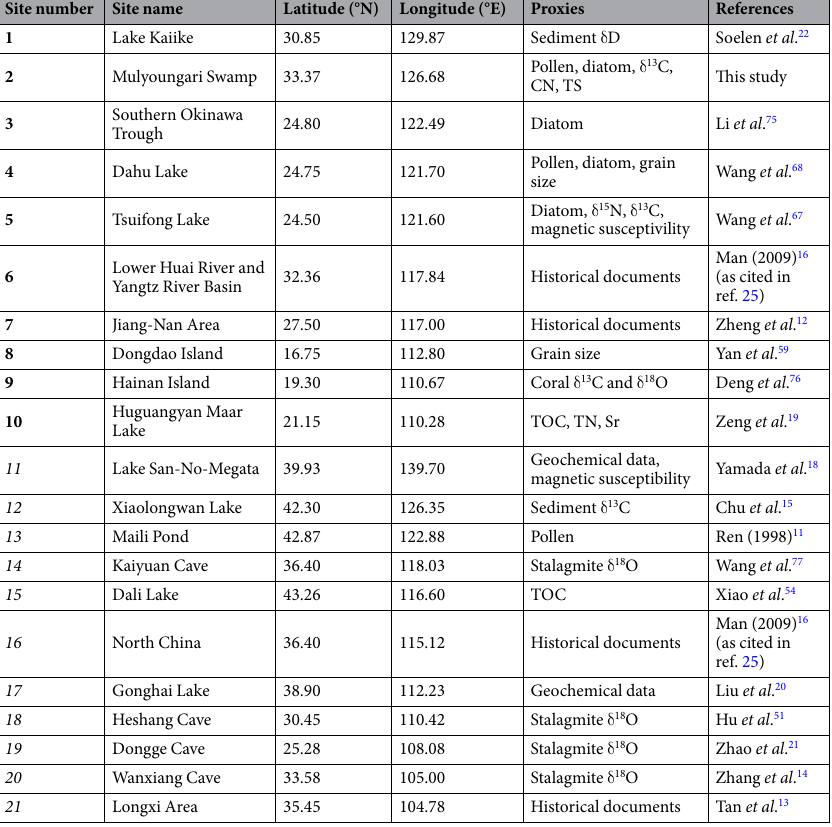
Table 1. Paleohydroclimate records used in this study. Coastal sites showing the dry MCA/wet LIA pattern are indicated by bold numbers (1–10) while other sites are by italic numbers (11–21) (see Fig. 5 for the location of each